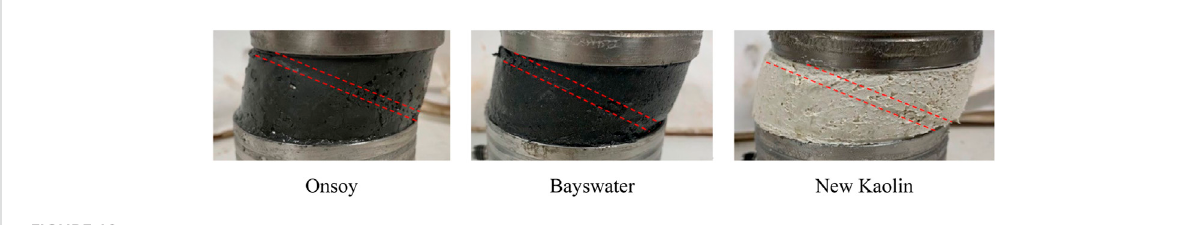
FIGURE 10 Photographs of typical failure planes in a Berkeley simple shear device.